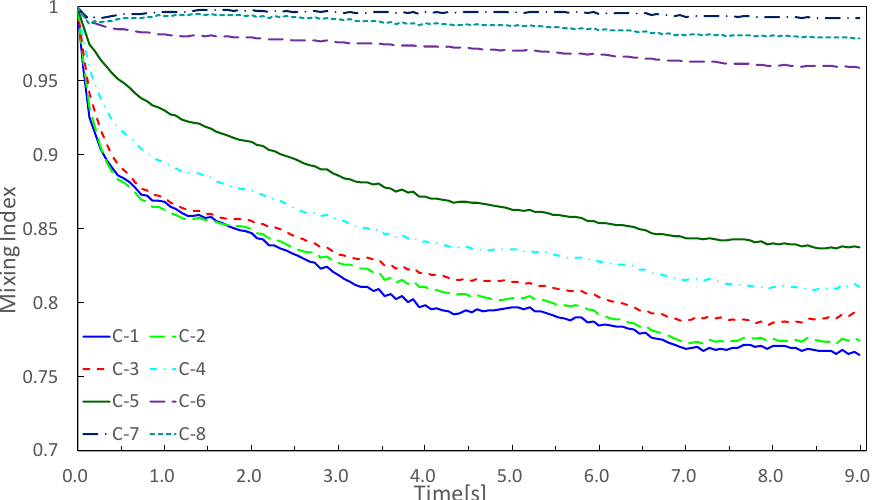
Figure 9. Average of nine experiments was calculated, and graph shows the simple moving average. Final concentrations were C-1, -2, -3, -4, -5, -6, -8, and